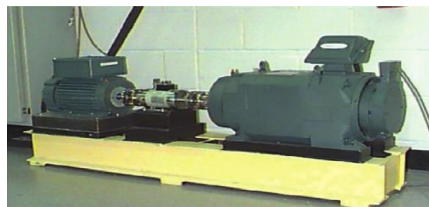
Figure 2: Experimental platform 1